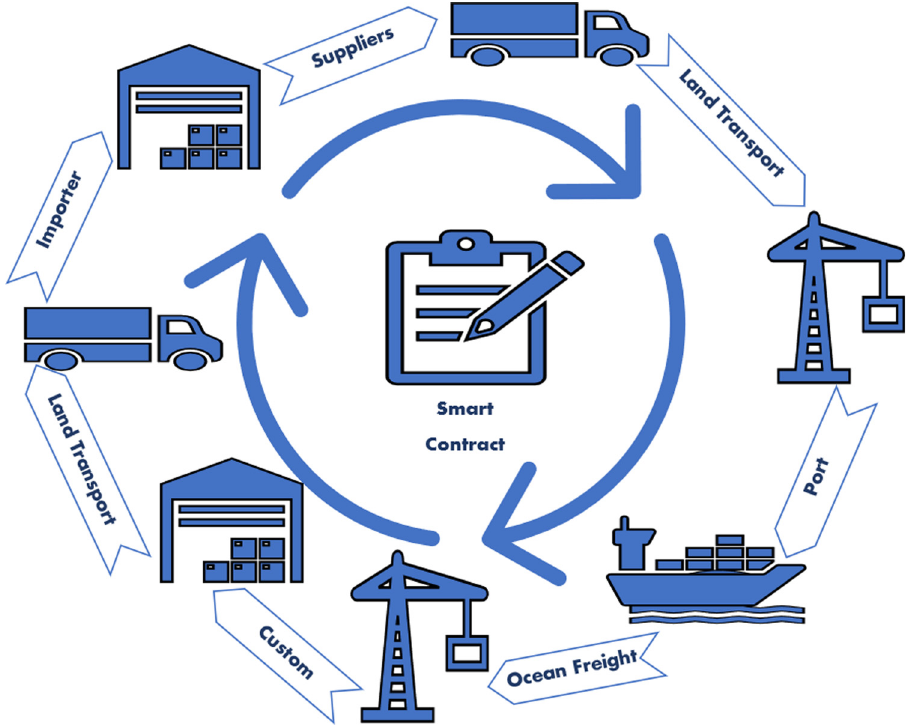
Figure 2: Blockchain - based SC management work fl